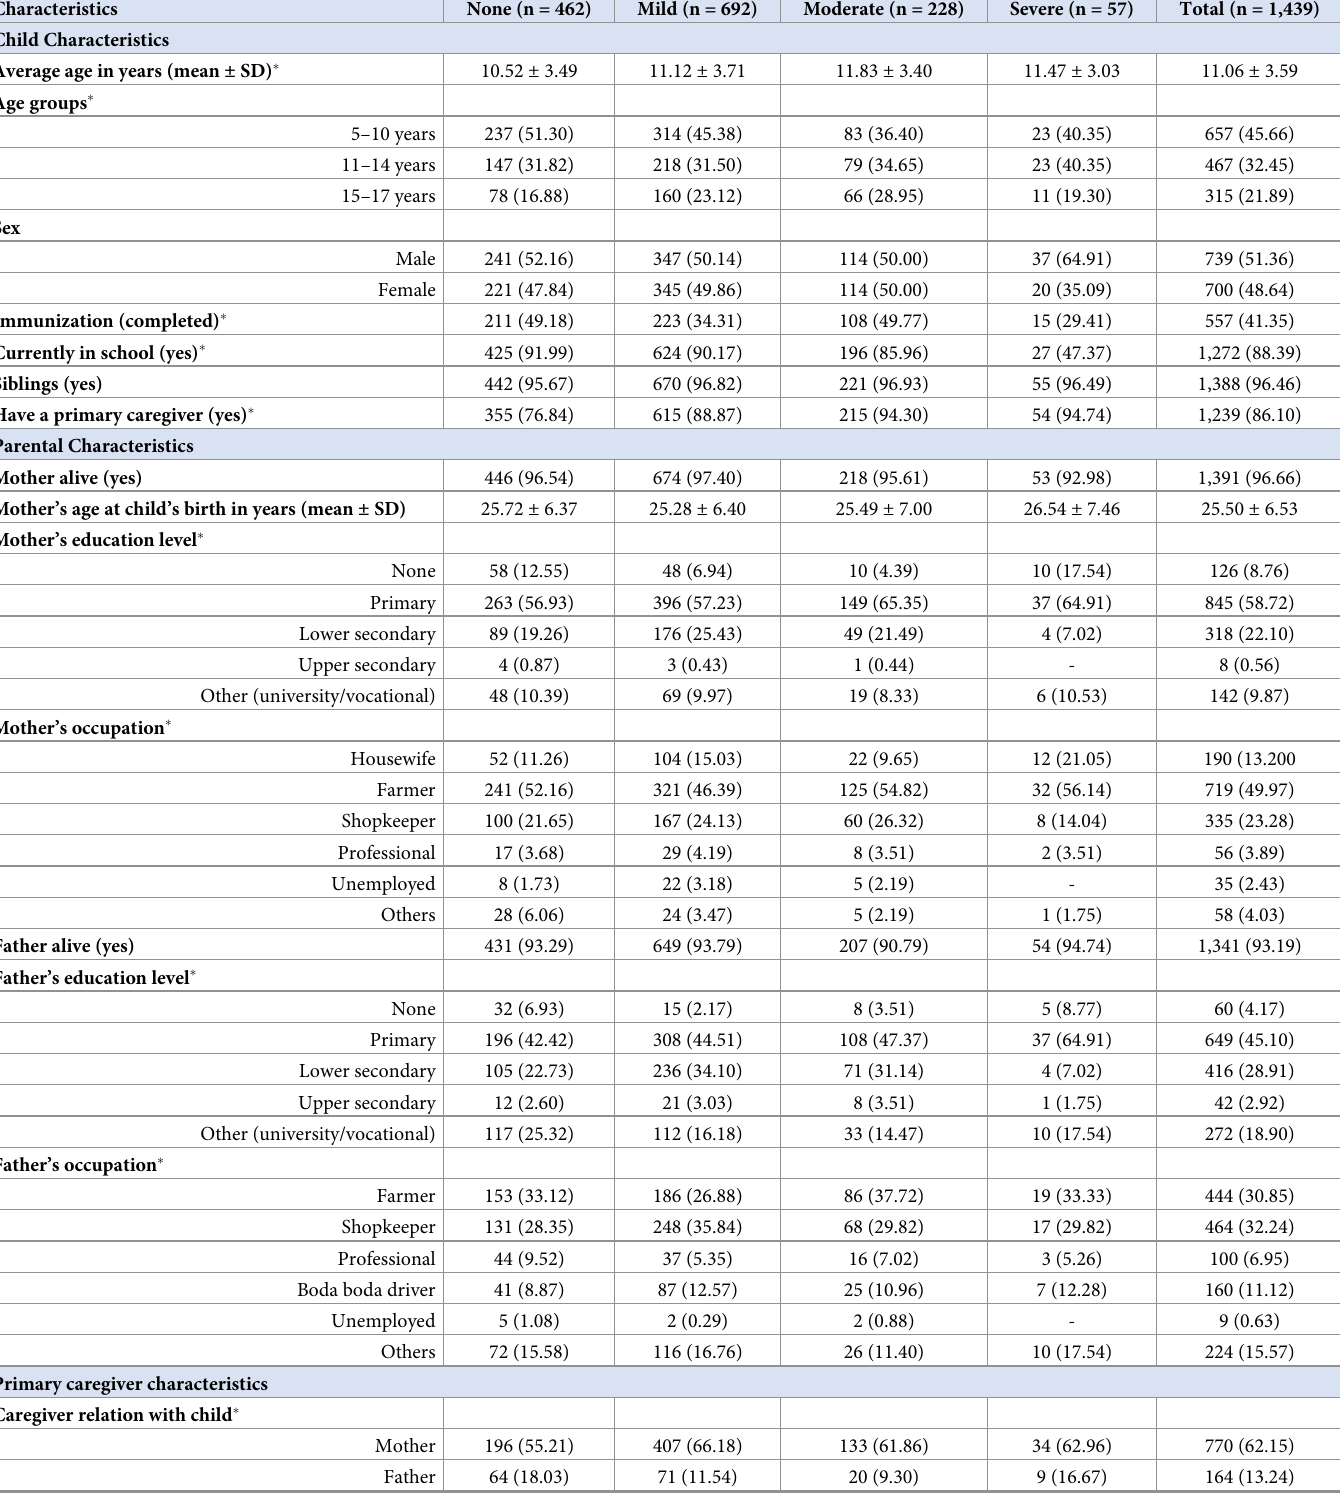
Table 4. Distribution of child, parent, primary caregivers, and household characteristics by disability categories (n = 1,439).